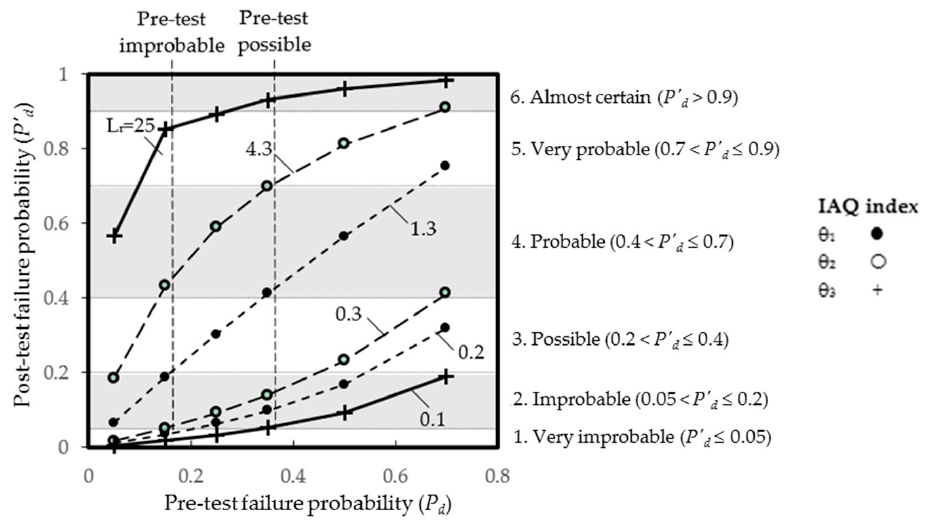
Figure 2. Results of pre- and post-test probabilities (with corresponding verbal probability expressions) under different screening levels. L r : Likelihood ratio.